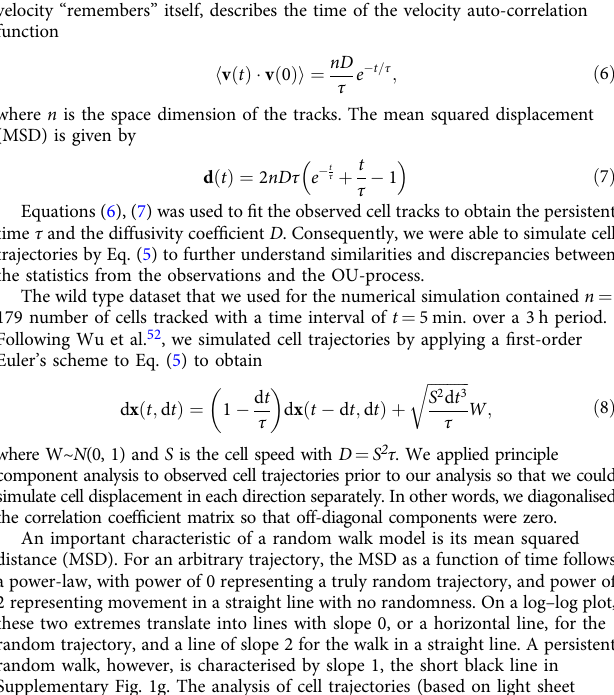
Fig. 7 Wnt5a is a spatial cue and Yap/Taz and Piezo1 act downstream of Wnt5a . a Sox:Cre;Z/Wnt5a embryos expressed Wnt5a beyond the normal expression domains by in situ hybridisation. b OPT showing a short and wide mandibular arch in a 21 somite Sox:Cre;Z/Wnt5a embryo. c F-actin and pMLC biases were diminished in 20 – 21 somite Sox:Cre;Z/Wnt5a embryos. d Proportion of cells exhibiting nuclear YAP in the Wnt5a − / − mandibular arch. Scale bars: 20 μ m. e OPT showing phenotype of T:Cre;Yap f/ + ;Taz f/f mandibular arch. f Orientation of mesenchymal cell intercalations in the sagittal plane of mandibular arch mid-regions of WT and T:Cre;Yap f/ + ;Taz f/f embryos. Intercalation angles were binned into one of 4 arcs of 90 o each: anterior, posterior, proximal and distal ( n for WT = 48, n for mutants = 42, where n = No. of groups of 5 – 7 cells). g Multiple vinculin force curves showed no difference in the variance (amplitude) of fl uorescence lifetime values of Yap f/ + ;Taz f/f and Tcre;Yap f/ + ;Taz f/ middle mesenchymal cells (p = 0.185, ANOVA, n = 16 cells in each of two 20 – 21 somite embryos per condition). h PIEZO1 immunostain intensity was diminished in the Wnt5a − / − mandibular arch. Scale bars: 20 μ m. i The 21 somite Piezo1 − / − mutant mandibular arch partially phenocopied that of Wnt5a − / − with a short and broad mid-portion. j YAP/TAZ and PIEZO1 partially mediate actomyosin bias and cortical oscillation amplitude, respectively, downstream of WNT5A to orient and promote mesenchymal cell intercalations. Source data are provided as a Source Data